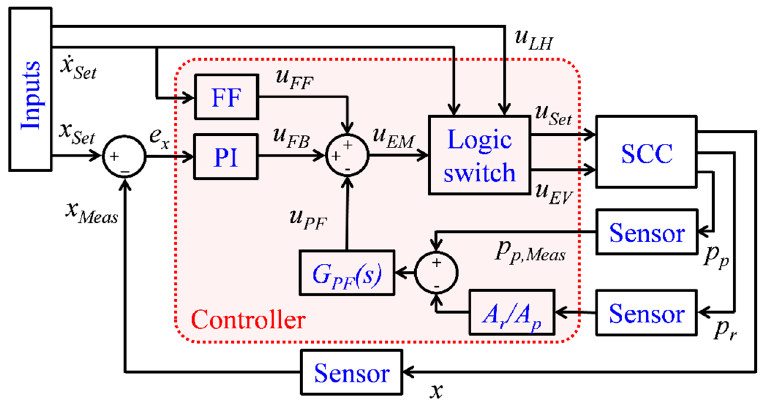
Figure 4. Block diagram of the control algorithm.